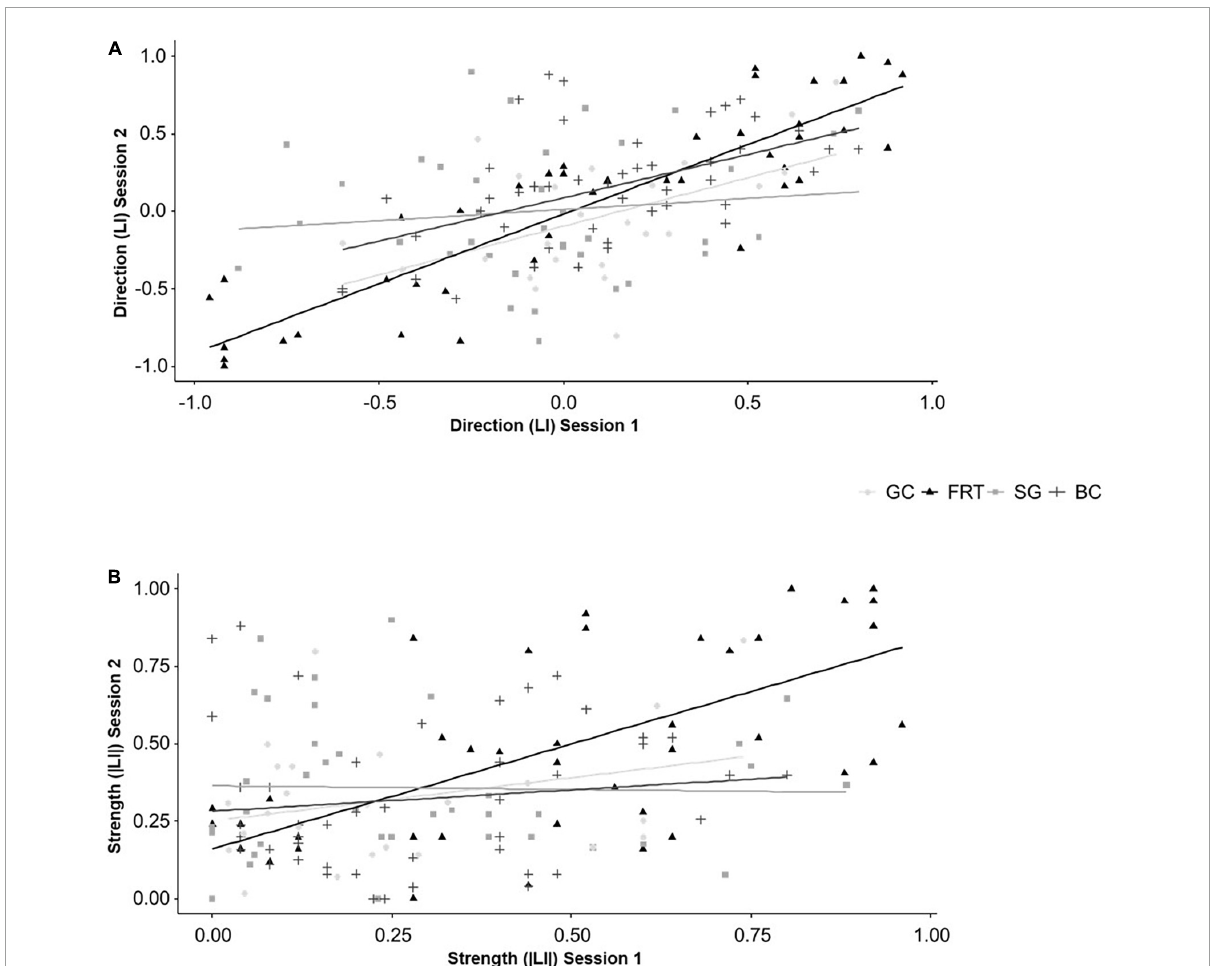
FIGURE5 Temporal consistency of lateralized behaviors. (A) The direction (LI) and (B) the strength (|LI|) of lateralization of mice from three different genotypes (5-HTT +/+, 5-HTT +/ − and 5-HTT − / − ) for four different behaviors [grid climbing (GC), food-reaching (FRT), self-grooming (SG), and barrier crossing (BC)] was observed in two sessions (5 weeks apart). Because the genotype did not influence the temporal consistency, the data of all three genotypes was pooled for the graphical presentation. Statistics: Spearman correlations; Sample sizes: GC LI = | LI | = 24, FRT LI = | LI | = 43, SG LI = | LI | = 37, BC LI = | LI | = 47. Regarding the direction (LI), the FRT and BC were temporally consistent. Regarding the strength (|LI|), the FRT was temporally